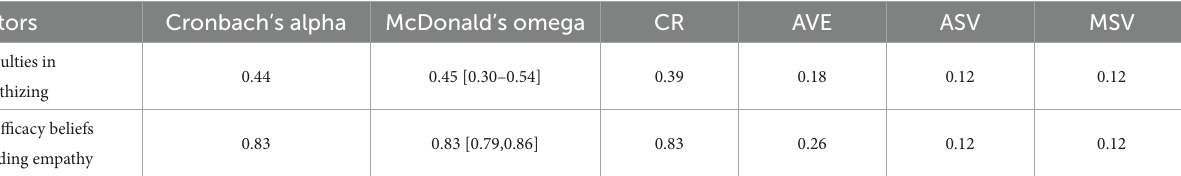
TABLE 2 Validity measures of Model 3 from the